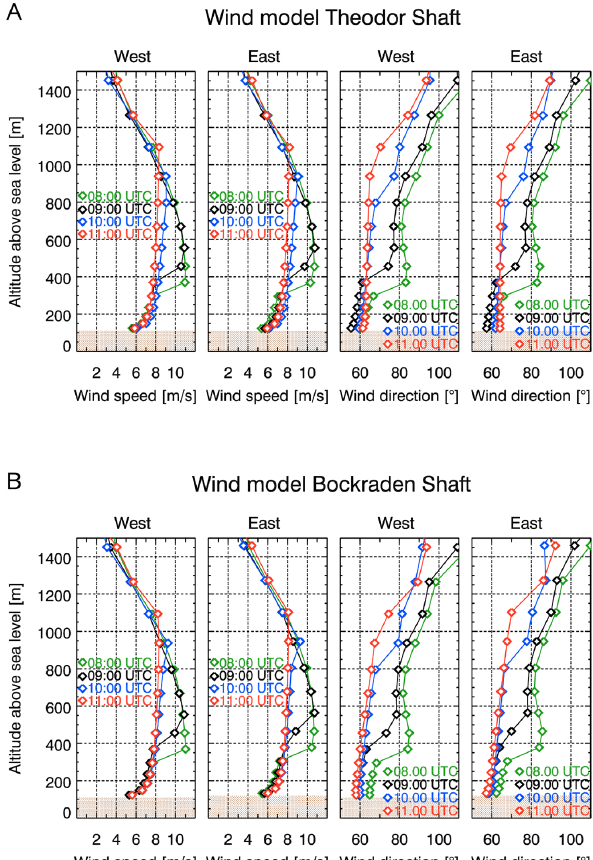
Fig. 6. Panel (A) : wind speed and direction for the model grid points west (52.2794 ◦ N, 7.7540 ◦ E) and east (52.2801 ◦ N, 7.7948 ◦ E) of the location of Theodor Shaft. Panel (B) : same as panel (A) but for model grid points east (52.3036 ◦ N, 7.7120 ◦ E) and west (52.3043 ◦ N, 7.7528 ◦ E) of Bockraden Shaft. Local time was UTC +